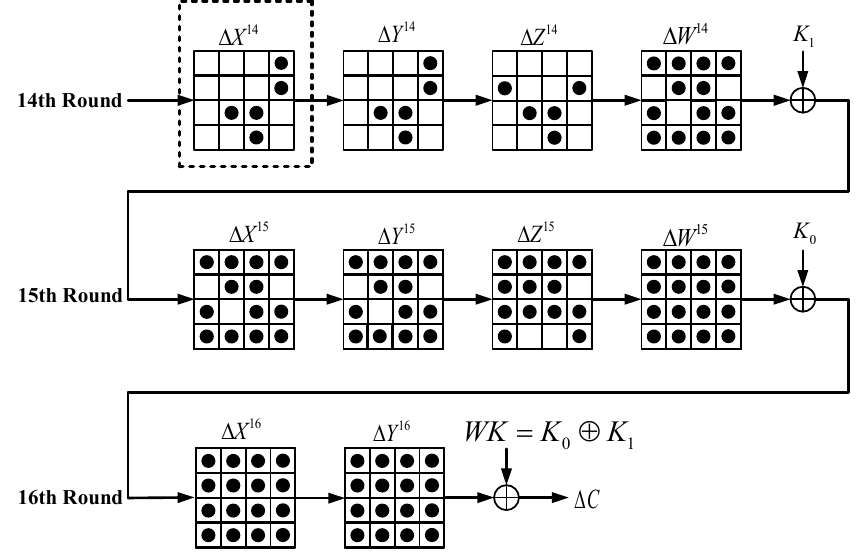
Figure 7. Random multiple faults’ propagation paths.